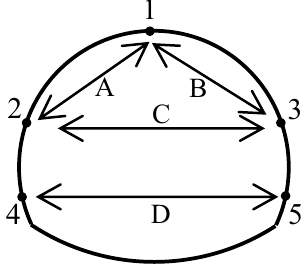
Fig. 3 Monitoring section for the displacements 1–5 and the defini- tion of convergences A–D, viewing from 10 the entrance to the face